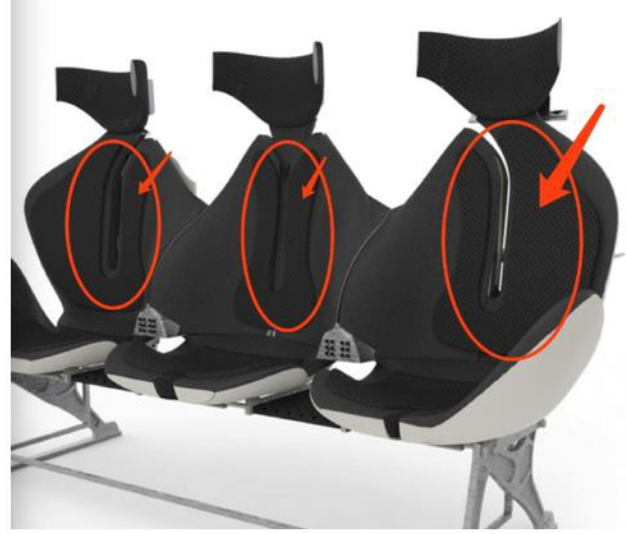
Figure 7. Sensors installed behind the cushion.